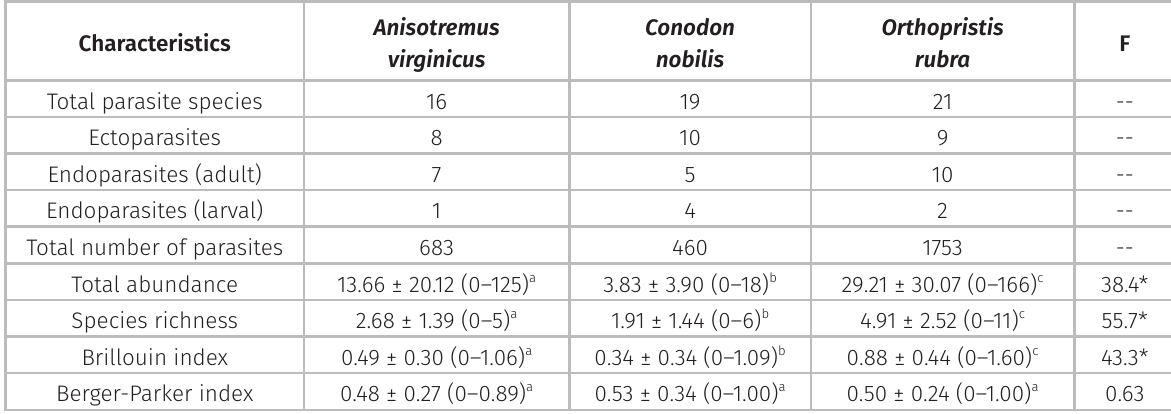
Table III. Descriptors of parasite communities of Anisotremus virginicus , Conodon nobilis and Orthopristis rubra from the coastal zone of Rio de Janeiro, Brazil, represented as mean followed ± 1 standard deviation (range). Superscript letters indicate statistical differences (ANOVA, p < 0.05) among values within the same